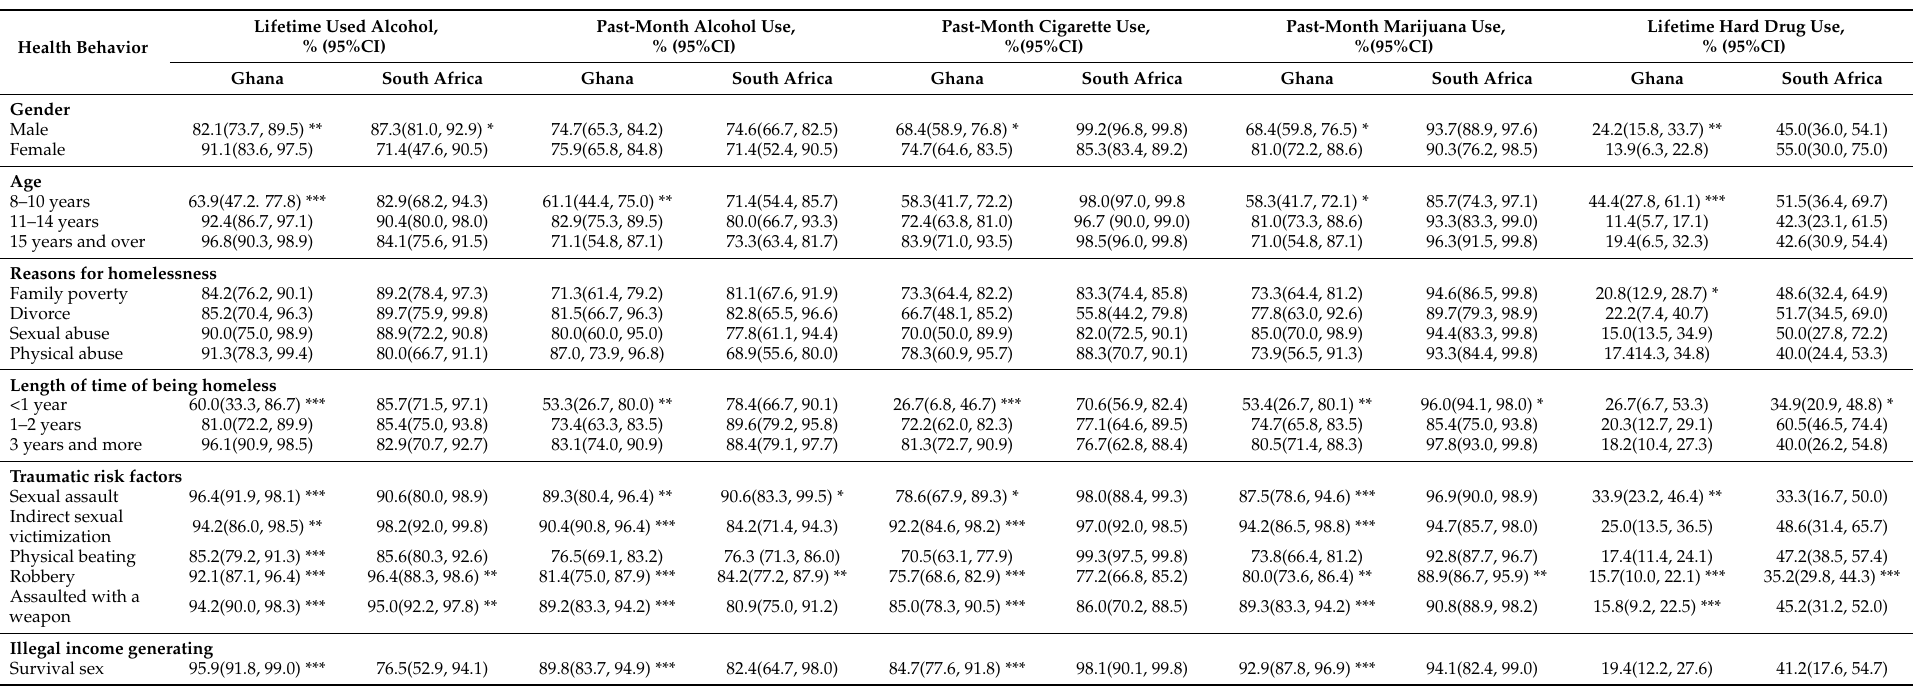
Table 1. Substance use prevalence rates among homeless children by sociodemographic and psychosocial characteristics: Ghana and South Africa. Health